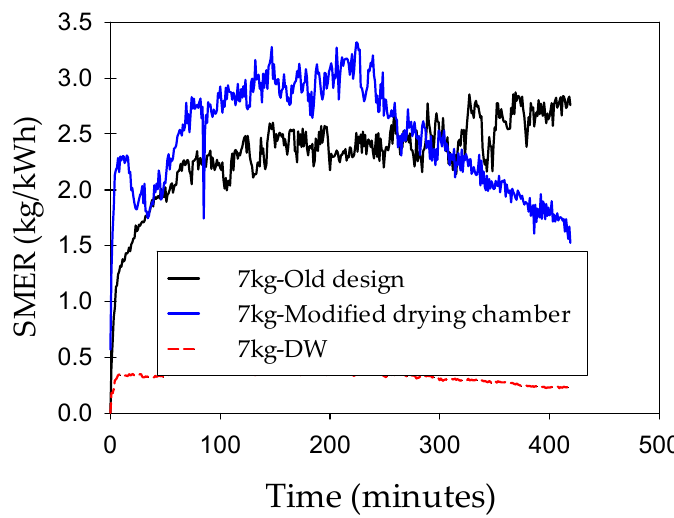
Figure 16. Specific moisture extraction rate versus drying time.